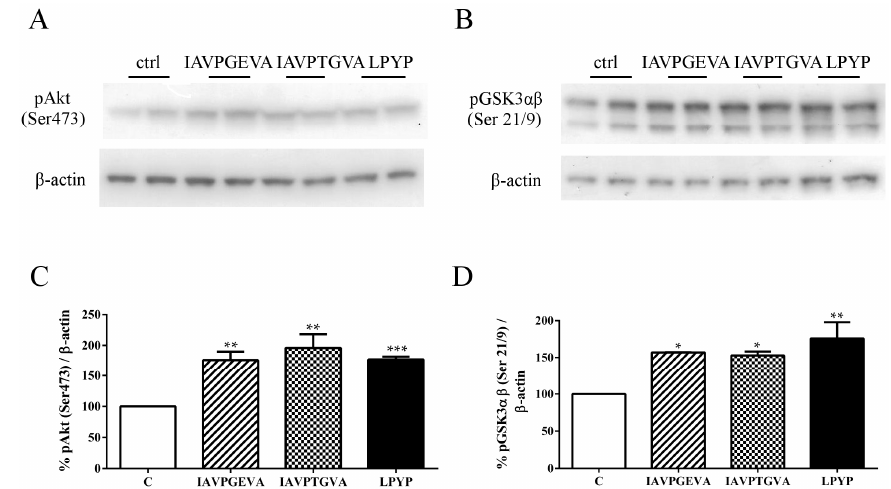
Figure 1. Effect of peptides on Akt/glycogen synthase kinase 3 αβ (Akt/GSK3 αβ ) pathway. HepG2 cells (1.5 × 10 5 ) were treated with Ile-Ala-Val-Pro-Gly-Glu-Val-Ala (IAVPGEVA) (500 μ M), Ile-Ala-Val-Pro-Thr-Gly-Val-Ala (IAVPTGVA) (500 μ M) and Leu-Pro-Tyr-Pro (LPYP) (500 μ M) for 24 h. ( A , B ) Exemplary western blot analyses of phosphorylated Akt (Ser473) and phosphorylated GSK3 αβ (Ser21/9) levels after treatment. Signals were detected using specific anti-phospho-Akt (Ser473), anti-phospho-GSK3 αβ (Ser21/9) and anti- β -actin primary antibodies (loading untreated sample); ( C , D ) Quantitative analyses of western blots. Phospho-Akt (Ser473) and phospho-GSK3 αβ (Ser21/9) band intensities were quantified by ChemiDoc (BioRad, Hercules, CA, USA) and normalized using β -actin signals. Bars represent averages of duplicate samples ± SEM of six independent experiments. * p < 0.05, ** p < 0.001 *** p < 0.0001 versus untreated sample. C, untreated sample; pAkt, phosphor-Akt; pGSK3 αβ , phospho-GSK3 αβ .